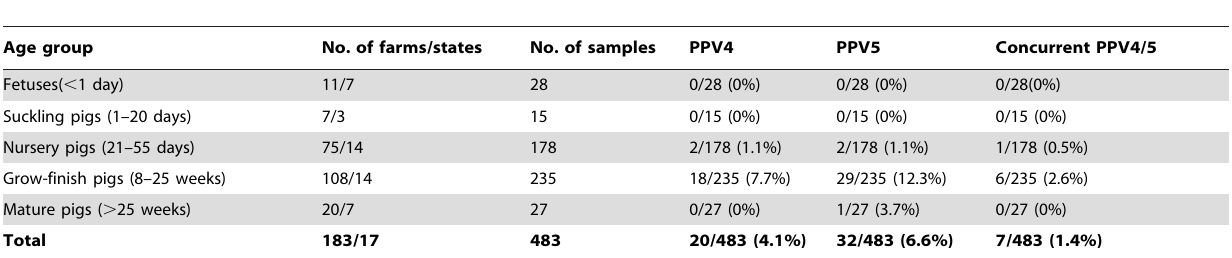
Table 1. Summary of the history (age, states, farms) and prevalence of PPV4, PPV5 or concurrent PPV4/5 DNA in lung samples obtained from 483 pigs located in the